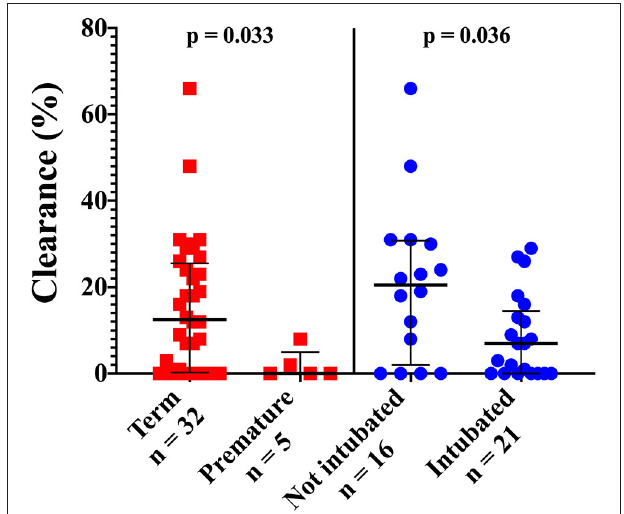
FIGURE 5 | Post-operative variables significantly associated with percentage of mucociliary clearance. Pre-mature infants (born < 37 weeks gestational age) and infants who were intubated during their mucociliary clearance scans had significantly lower mucociliary clearance than term patients and those who underwent cannula